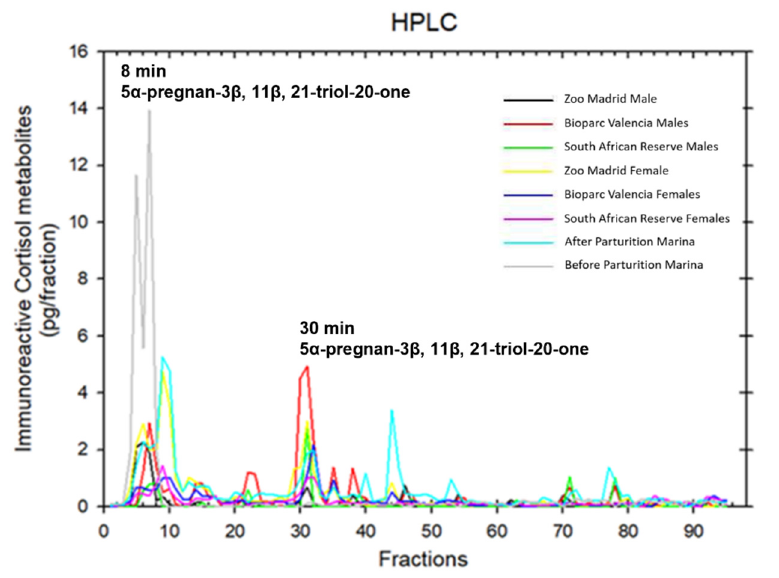
Figure 1. HPLC analysis of fecal glucocorticoid metabolites. Different colored lines refer to the different pools of samples prepared for HPLC that are specified.